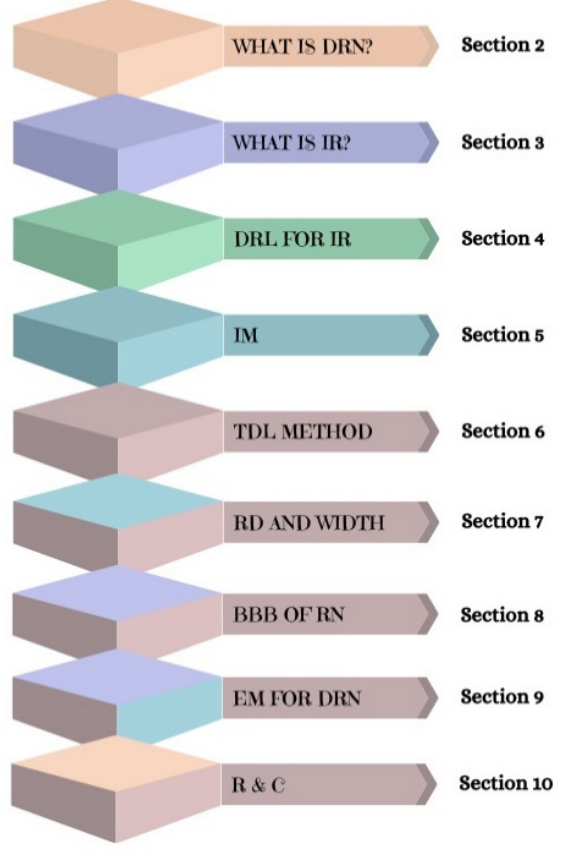
Figure 4. Sections Details. 2. What Is a Deep Residual Network?